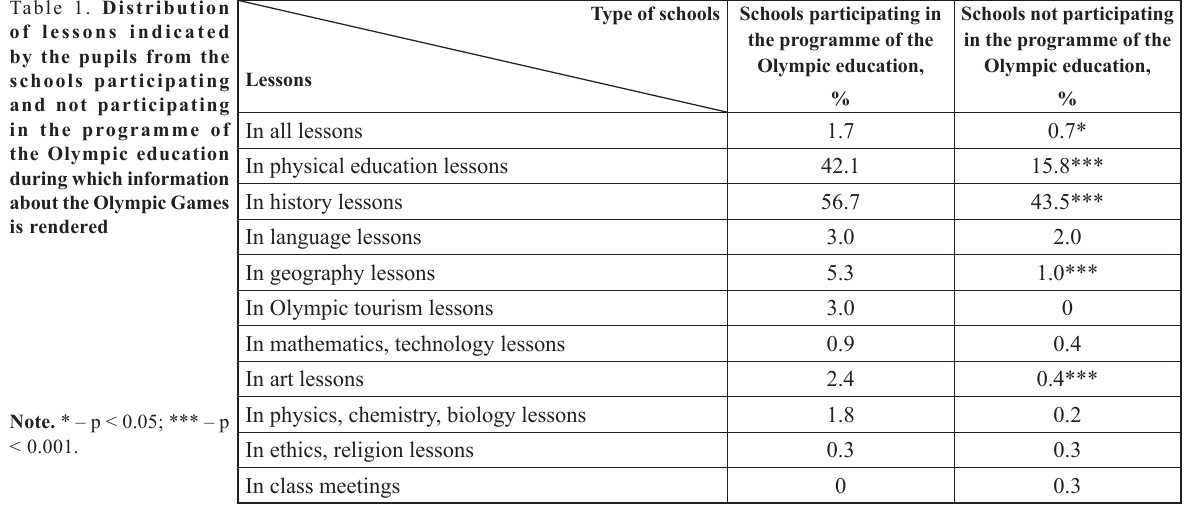
Table 1. Distribution of lessons indicated by the pupils from the schools participating and not participating in the programme of the Olympic education during which information about the Olympic Games is rendered